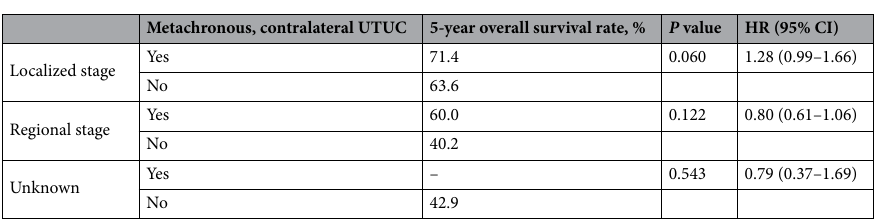
Table 3. Overall survival according to multivariate analysis in different groups. HR in multivariate analysis were adjusted for age, sex, race, bladder cancer presence, laterality, tumor location, the mode of surgery, tumor grade, tumor size. UTUC upper tract urothelial carcinomas, HR hazard ratio, CI confidence